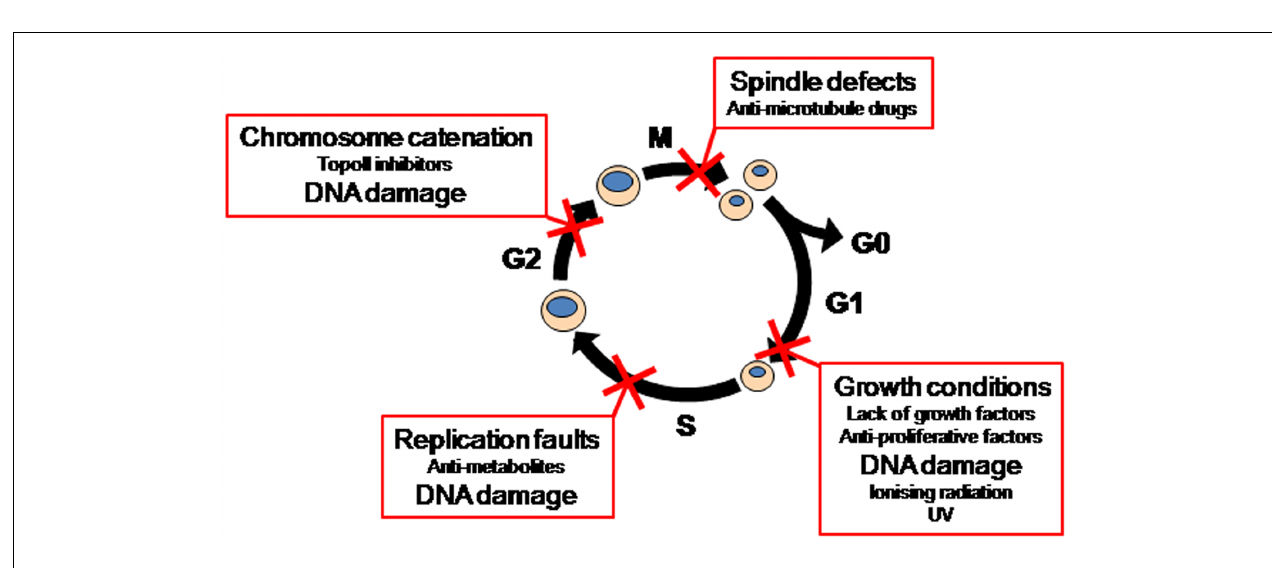
FIGURE 1 | Cell cycle